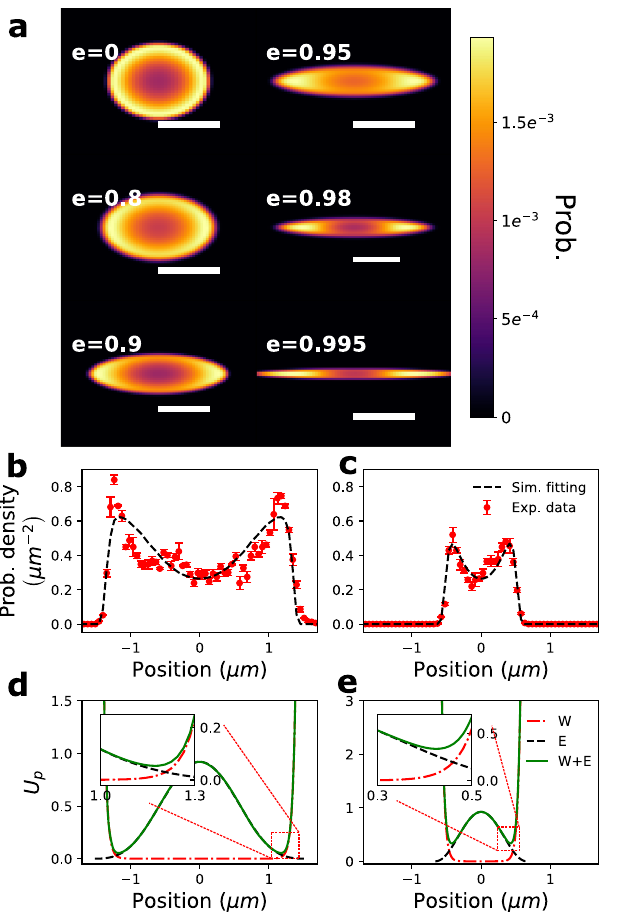
Fig. 5 Modeling the distribution of plasmid position and comparison with experimental data. a Fitted position distribution of the con fi ned plasmid in cavities containing a single T 4 -DNA molecule with eccentricity ranging from e = 0 to e = 0.995. The scale bars are 1 μ m, 1 μ m, 1.2 μ m, 1.2 μ m, 1.6 μ m and 1.6 μ m respectively for cavities with eccentricities ranging from e = 0 to e = 0.995. Plasmid probability density along the major ( b ) and minor ( c ) axis for e = 0.9. Experimental data are shown as red points, with error bars corresponding to the standard error of the mean of the binned counts ( n = 3 bins for each point). Black dashed lines indicate the resulting fi tted model plasmid probability density. Cross-sectional slices of the predicted potential along the major ( d ) and minor ( e ) axis for e = 0.9. The red dot-dashed line indicates the wall-potential; the black dashed line indicates the exclusion potential arising from the T 4 -DNA; the green solid line indicates the superposition of both potentials. Note that a potential well forms at the overlap region between the repulsive wall-potential and the self-exclusion potential, with the insets giving the detailed behavior of the potential in the well vicinity.